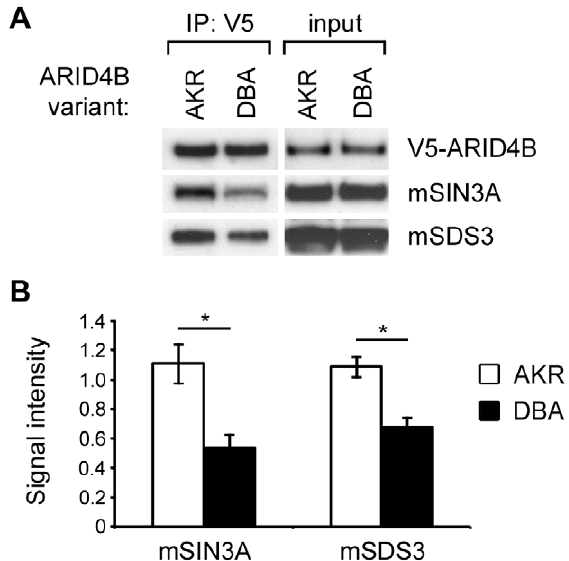
Figure 5. Differential binding of the AKR and DBA variants of ARID4B to the mSIN3A complex. Western blots (A) show equivalent input of V5-ARID4B, mSIN3A, mSDS3, and equivalent pull-down of the two variants using an anti-V5 antibody. Decreased binding of the DBA variant of ARID4B to mSIN3A and mSDS3 was observed relative to the AKR variant. Experiment was performed in triplicate and densitometry analysis (B) revealed a 51% reduction in mSIN3A binding (p=.037) and a 37% reduction in mSDS3 binding (p=.026) for the DBA variant relative to AKR. Statistical significance was determined using paired t-tests. *, p , .05.